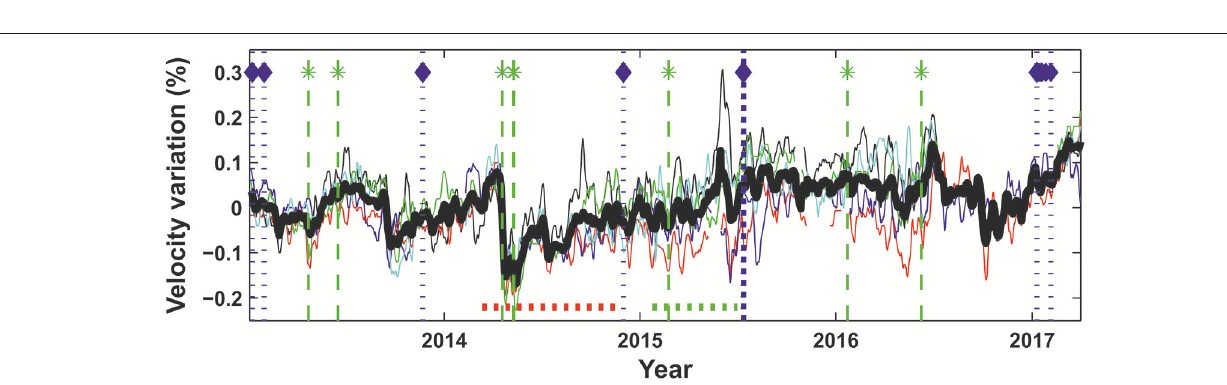
FIGURE 2 | Apparent velocity variations estimated for pairs EFRE-INCA (red), EFRE-SOMA (black), MNGR-INCA (blue), SOMA-JUBA (green), and SOMA-MNGR (cyan). Average velocity variation for the available pairs (thick dark line). Vertical dashed green lines indicate main regional tectonic earthquakes and vertical dashed blue lines indicate main eruptions. Horizontal dotted lines at the bottom of the graphic indicate periods of bad clock synchronization for stations SOMA (red) and INCA (green). The corresponding clock delays were corrected using noise cross-correlation (see main text for